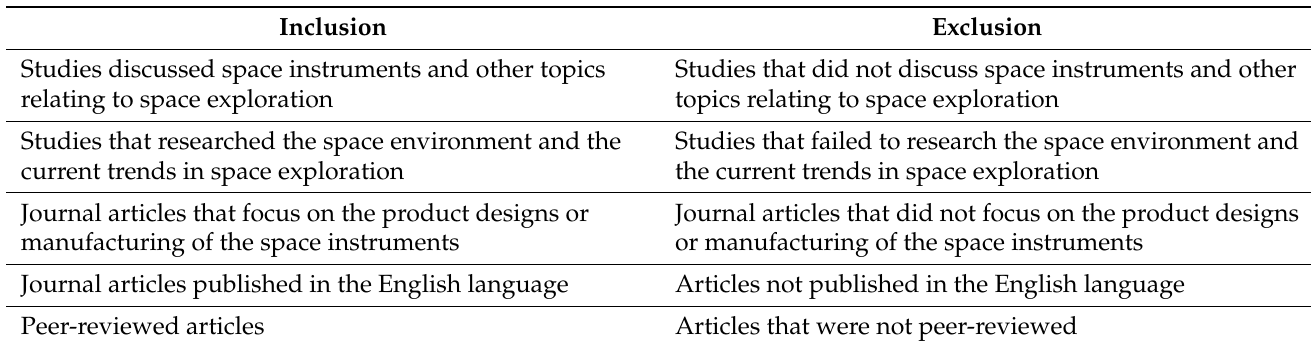
Table 1. Inclusion and exclusion